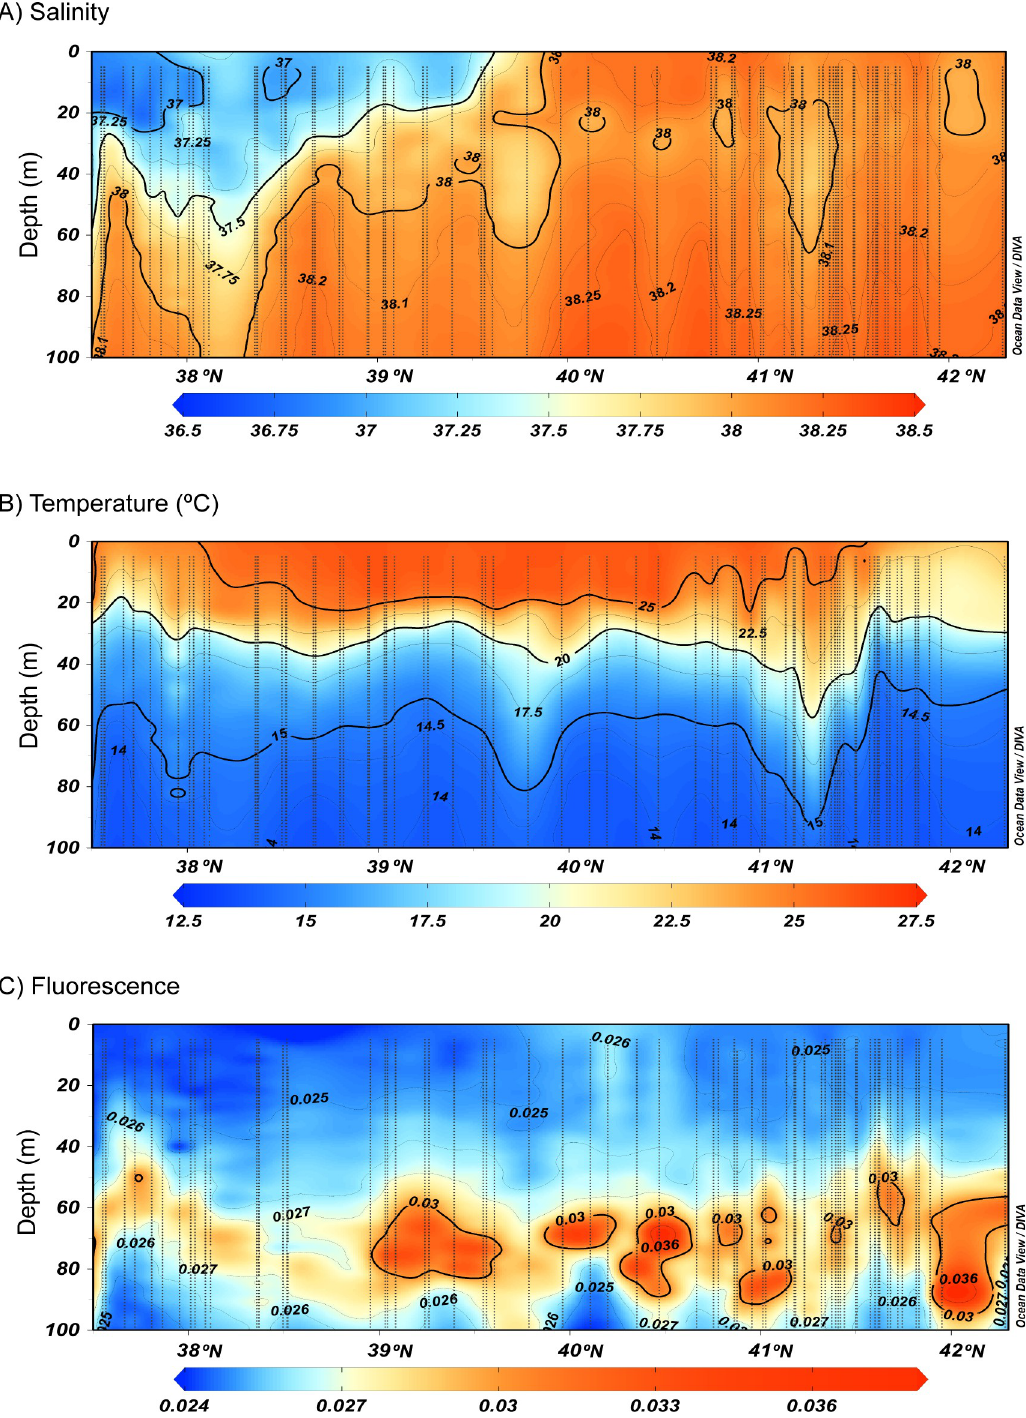
Fig 4. Vertical distribution of a) salinity, b) temperature and c) fluorescence in the upper 100 m depth from CTD data, along the continental slope. Horizontal axis indicates latitude range. Vertical dotted lines represent 1 m binned CTD profiles data.